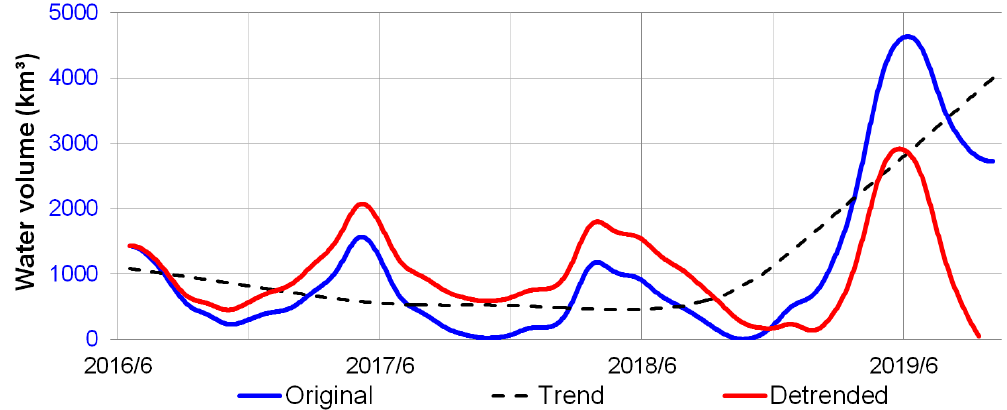
Figure 7. The detrended processing for Lake Urmia’s time series water volume estimation using the Seasonal-trend decomposition procedures based on Loess (STL). The estimated trend value and the original/detrended water volume are illustrated with the black, blue, and red lines, respectively.